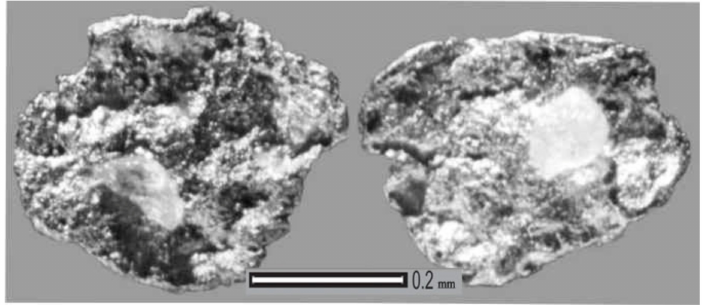
Figure 10. Surface of gold particles with casts of sand grains impressed in